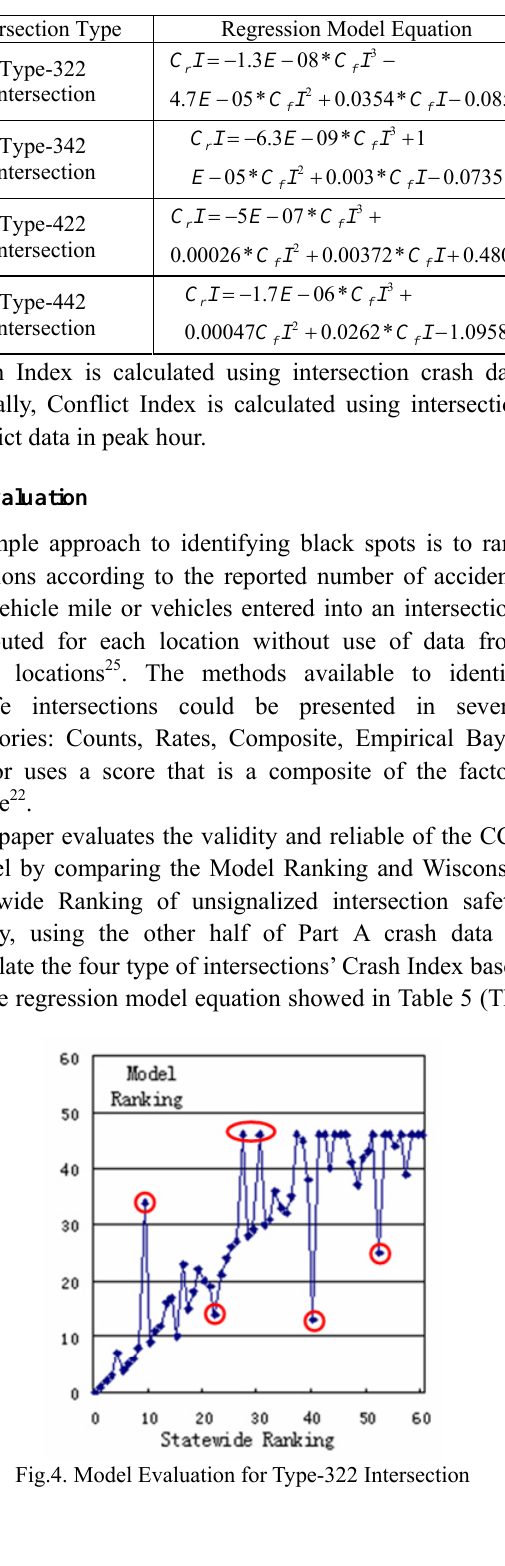
Table 5. CCS Model for Four Types of Unsignalized